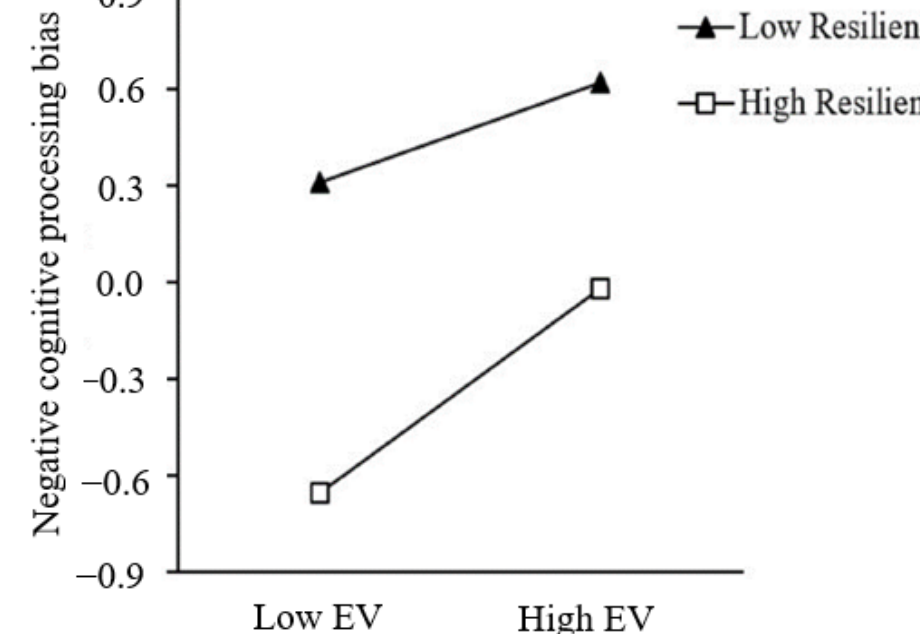
Figure 3. Resilience moderates the relation between early victimization and negative cognitive processing bias.